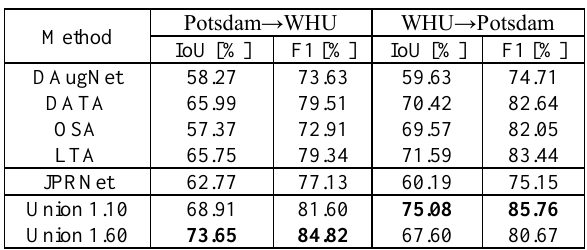
Table 3 . Comparison of the proposed Union method with other